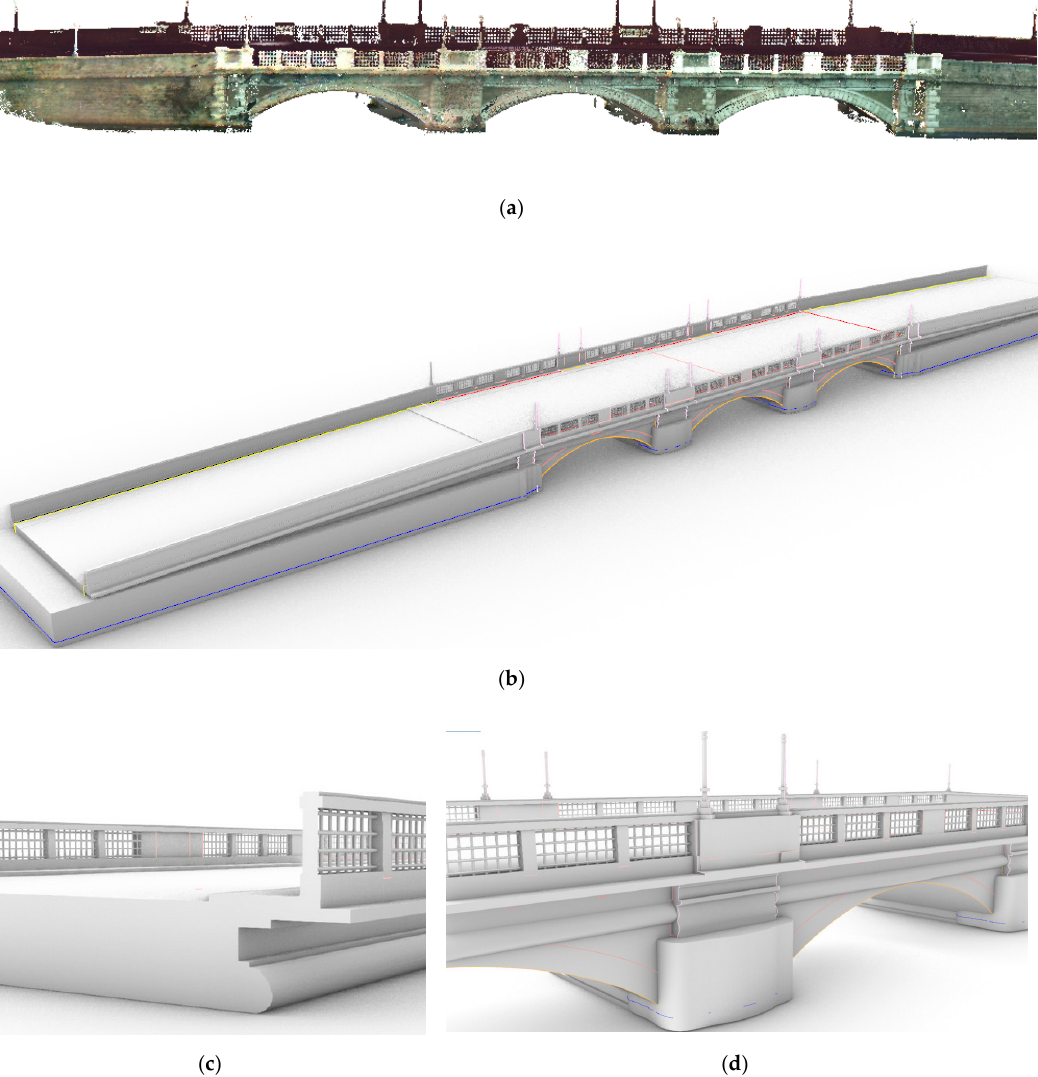
Figure 16. Three-dimensional representation of the bridge of “Porta Napoli”: ( a ) 3D point cloud; ( b ) 3D model of the masonry bridge; ( c , d ) details of the